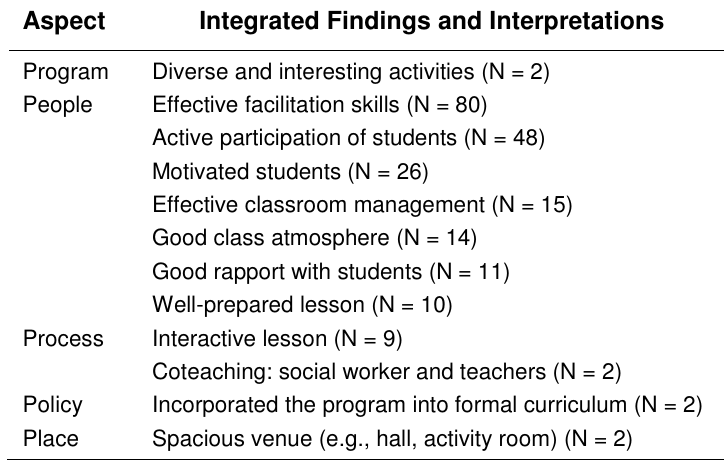
Factors Facilitating the Quality of Program Implementation Aspect Integrated Findings and Interpretations